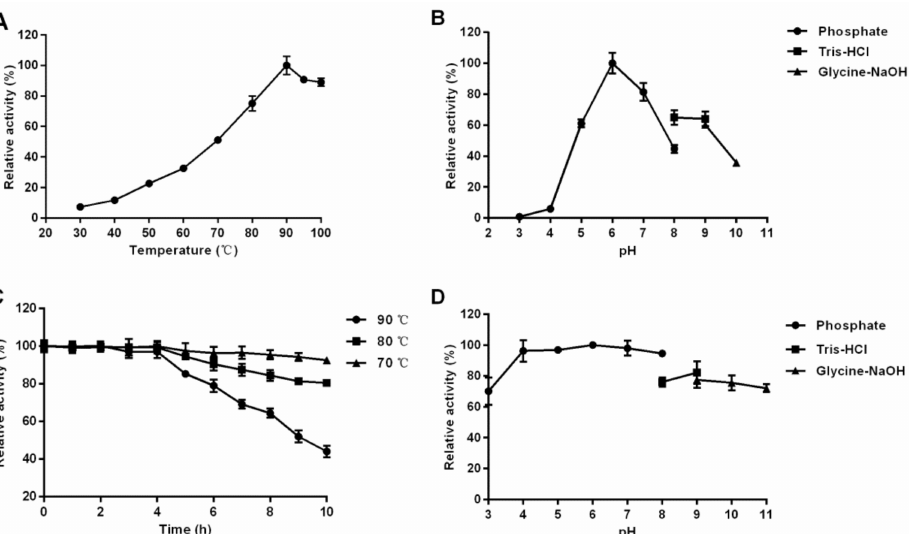
Figure 2. Enzymatic properties of recombinant TsBgl1. ( A ) effect of temperature on enzyme activity. ( B ) effect of pH on enzyme activity. ( C ) thermostability. ( D ) pH stability. The data of pH stability was shown as the residual enzyme activities measured under optimal conditions of enzymes incubated in buffers of different pH values at 4 ◦ C for seven days. The activity assays were performed using 4 mM p NP- β -Glc as